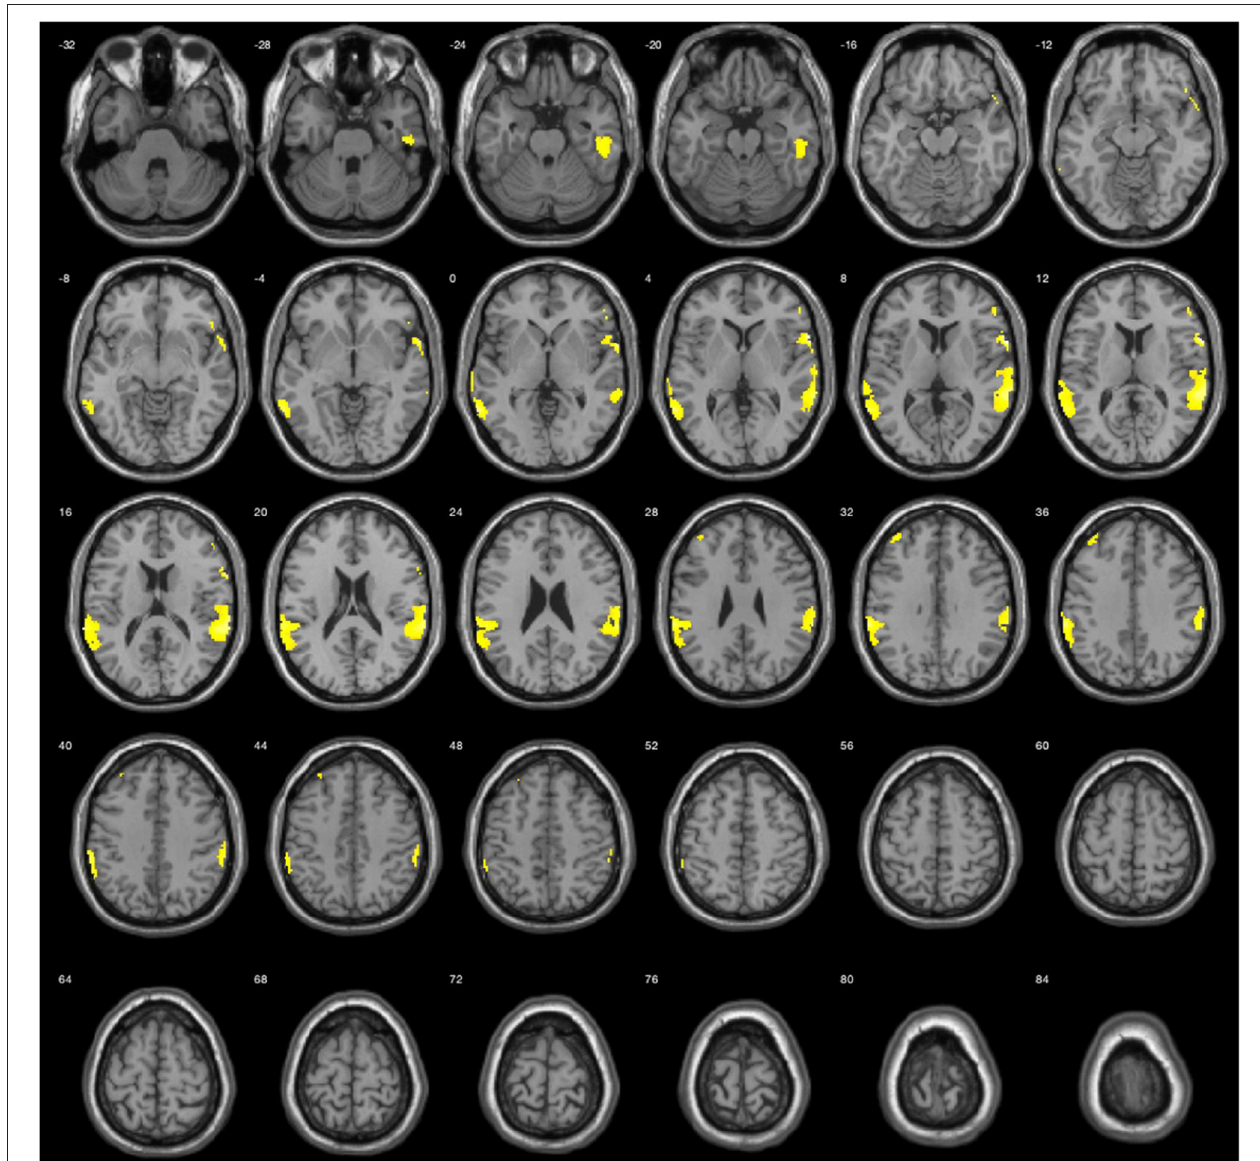
FIGURE 2 | Average activation maps resulting from group analysis, showing the increase of neural activation in myopic defocus relative to clear focus state. Color scale indicates score significance level.